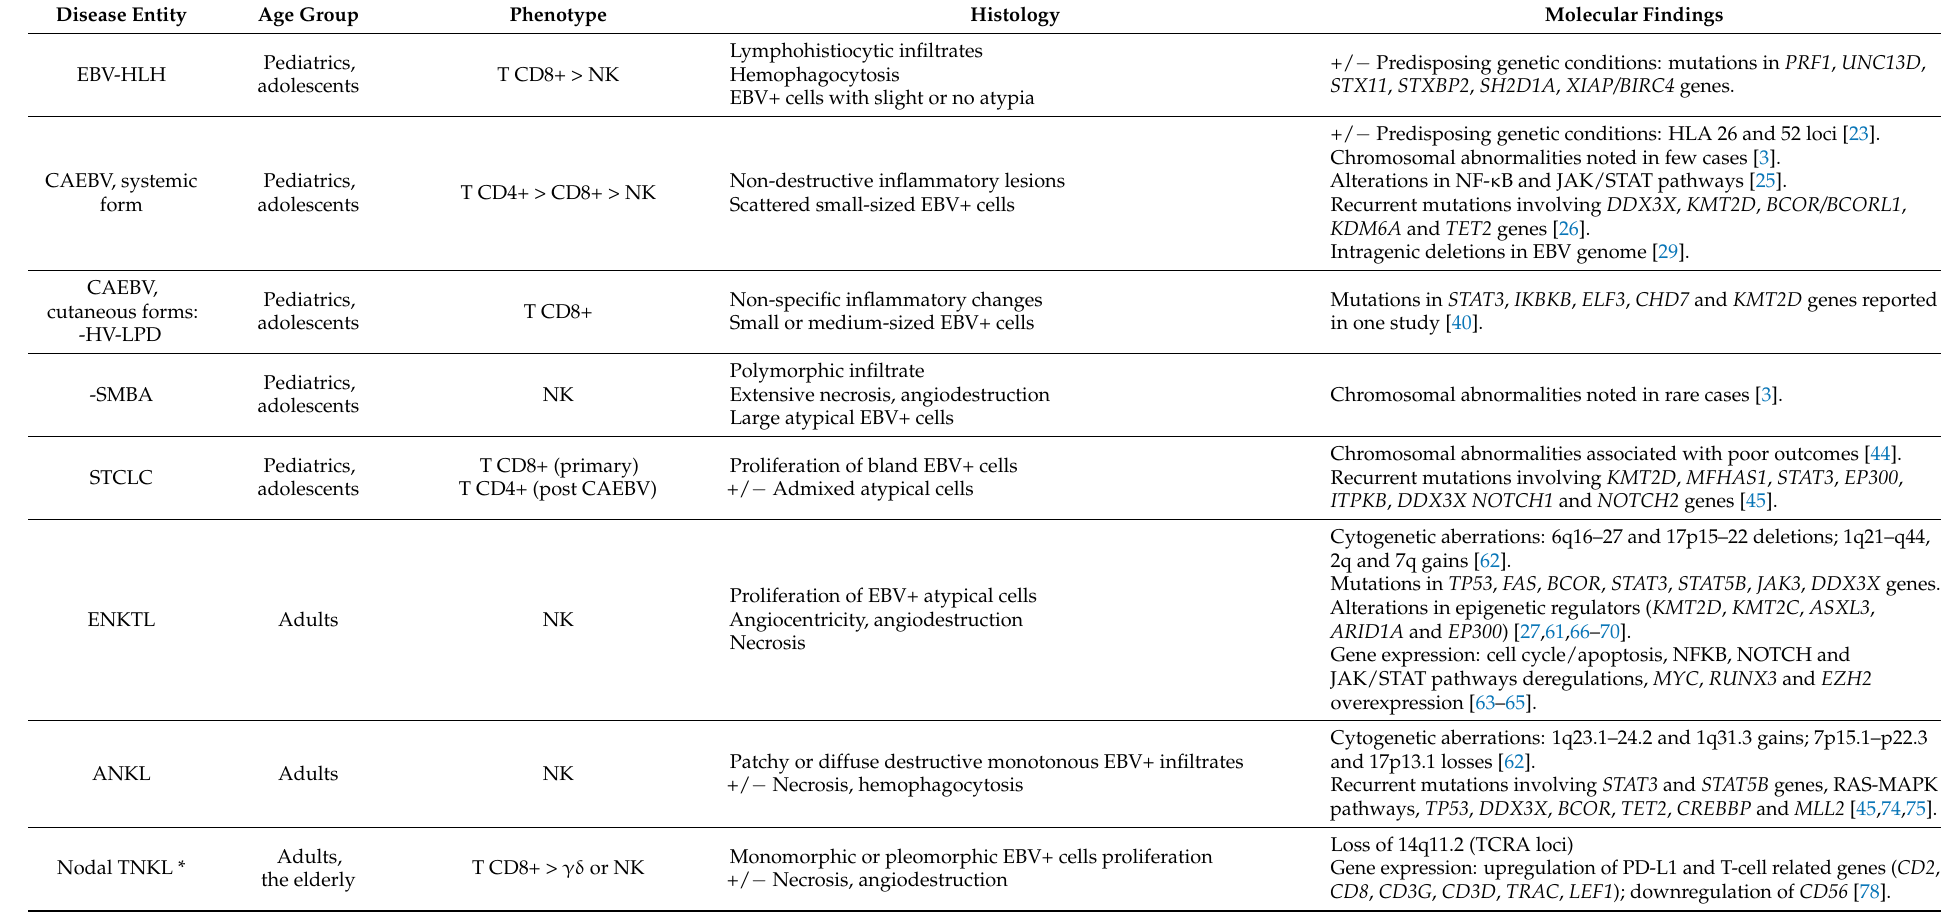
Table 1. Classification and characteristics of EBV-positive T- and NK-cells lymphoproliferative